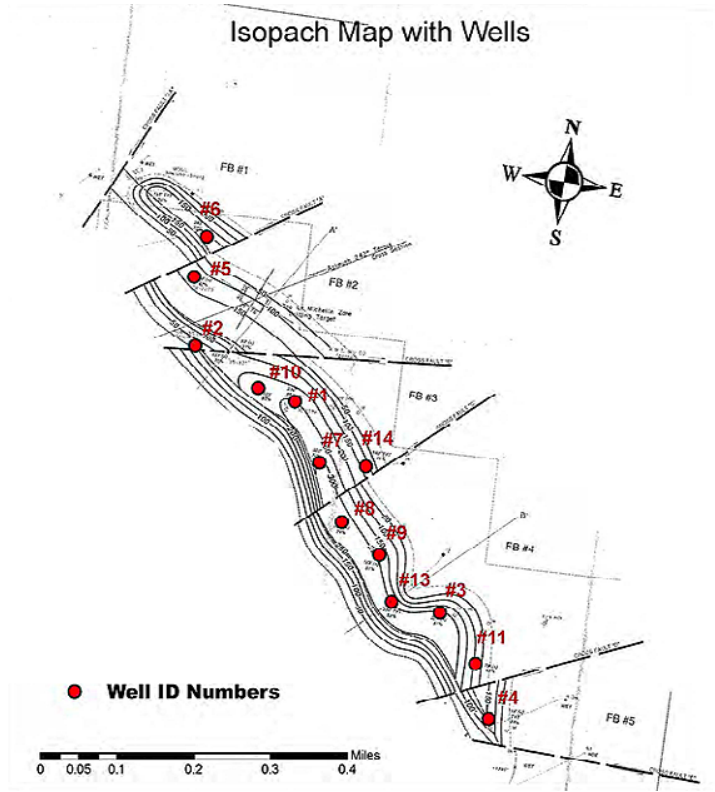
Figure 5. Isopach map of the Michelin Zone reservoir with drilled wells (Dorsey, 1993)